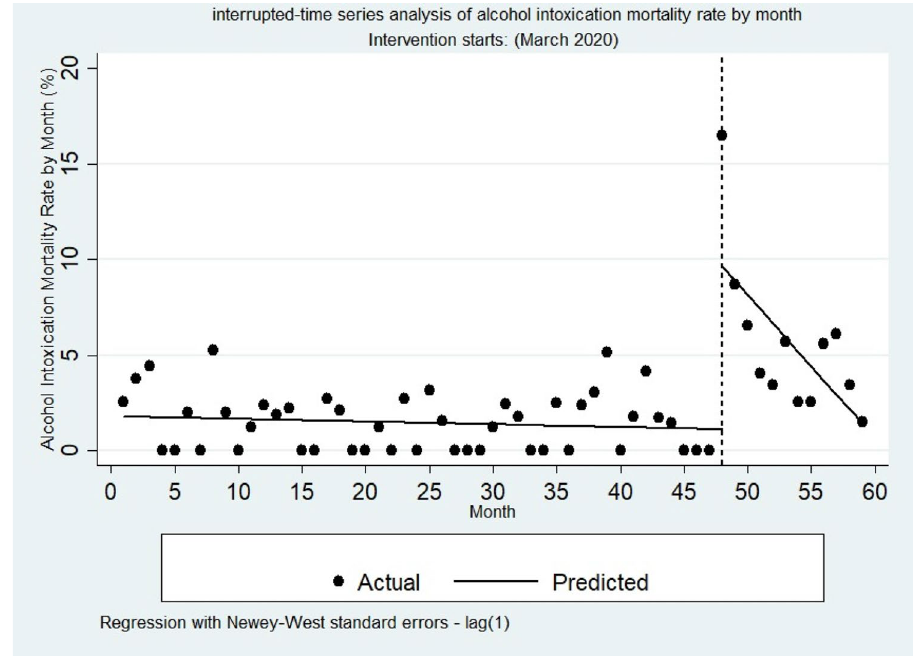
Figure 4. Interrupted time series of alcohol-related mortalities by